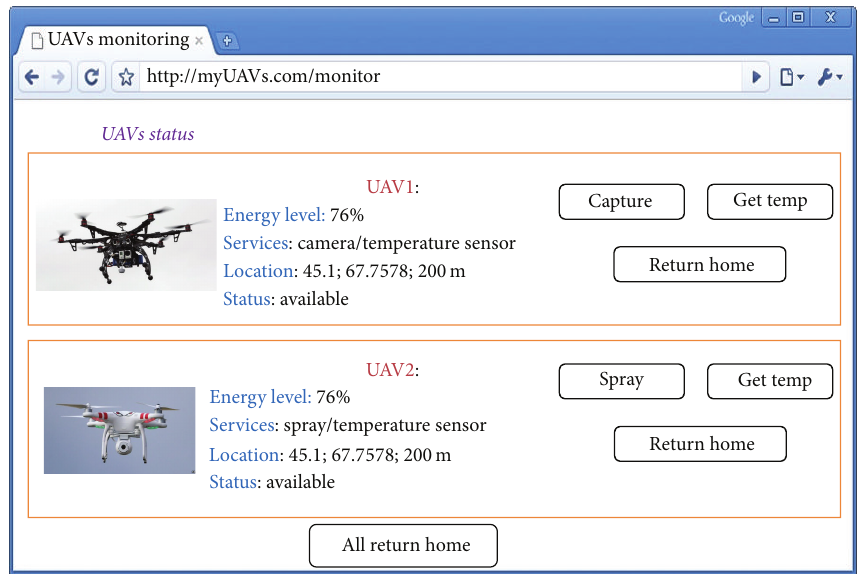
Figure 3: A user-friendly interface on browser of the client application for monitoring two UAVs.